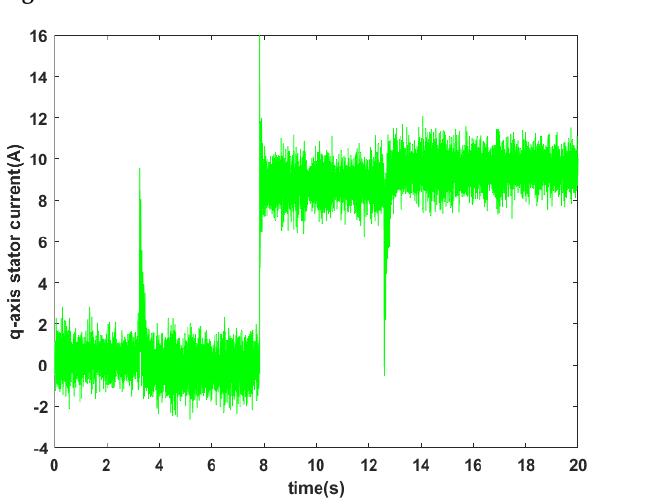
Figure 14. d-axis stator current.